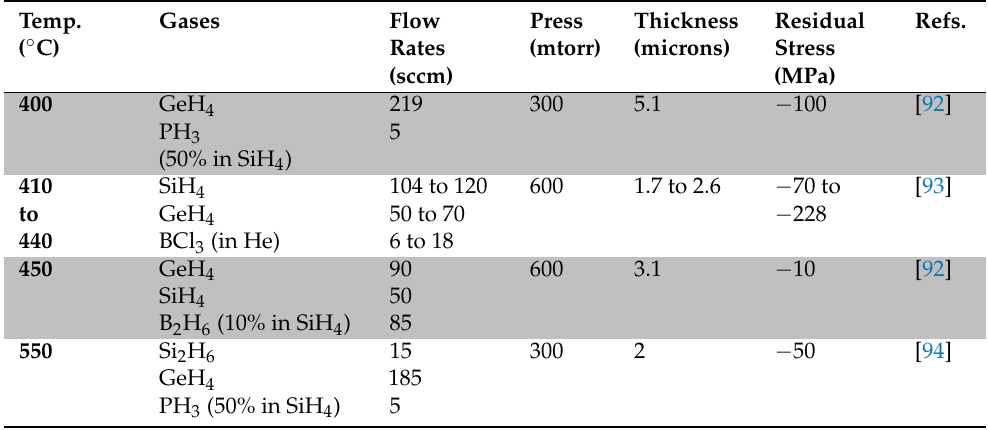
Table 5. Reported Residual Stresses of LPCVD Polycrystalline Silicon-Germanium (SiGe) for various process